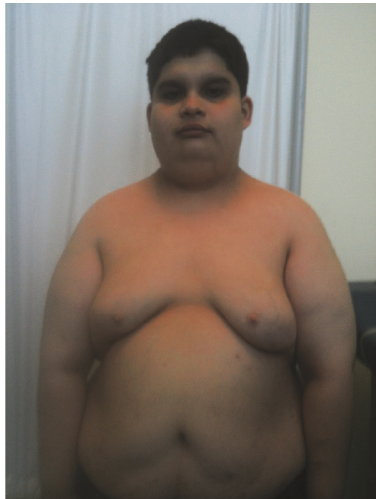
Figure 1: Characteristic facial features of Prader-Willi syndrome.